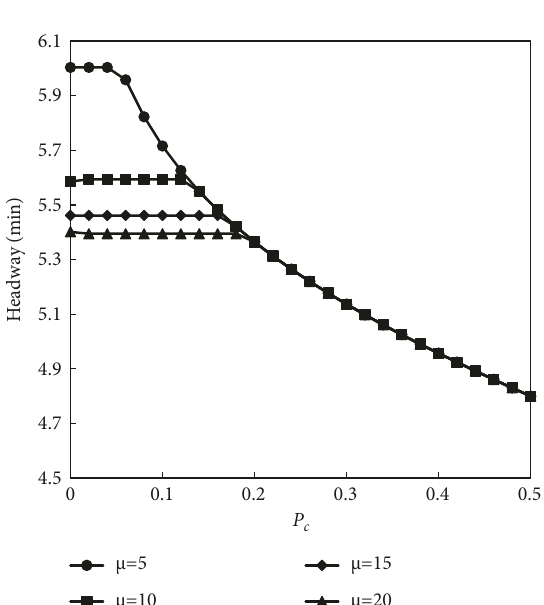
Figure 4: Optimal headway under different values of time.